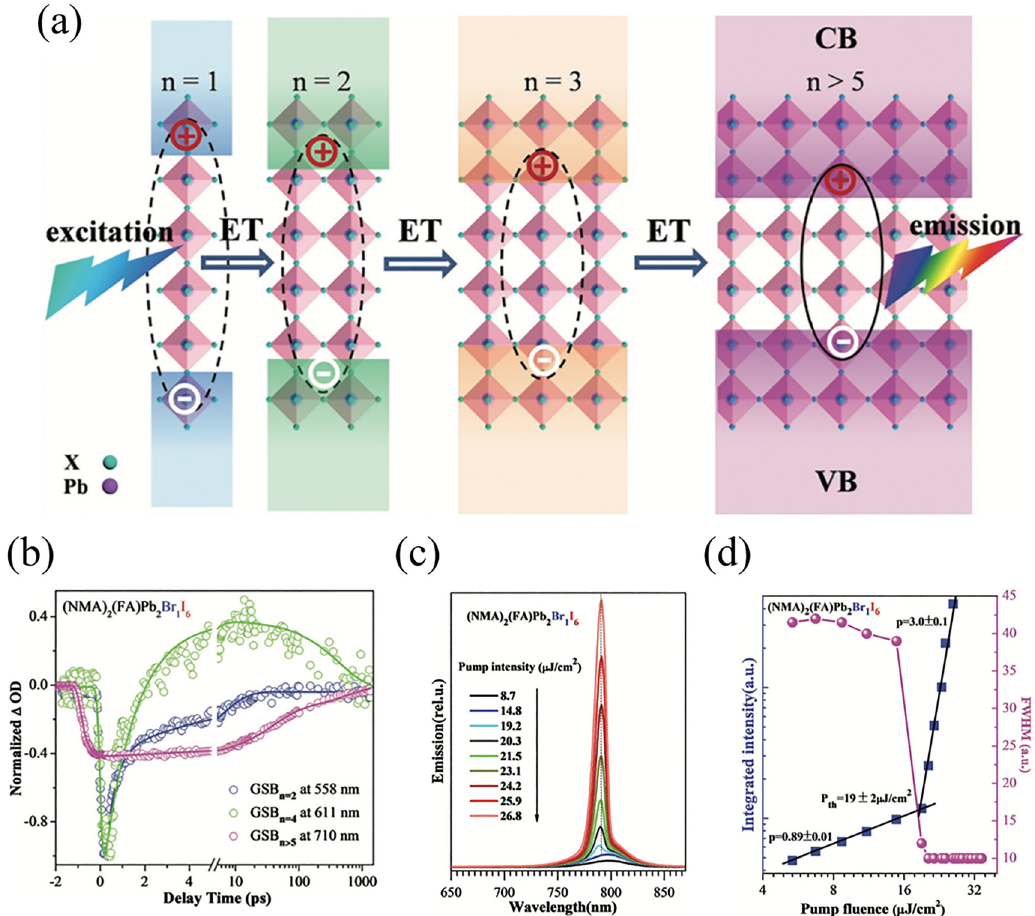
Figure 2: (a) The schematic diagram of cascade energy transfer from low- n domains with wide-bandgap to high- n domains with narrow bandgap. (b) Normalized bleaching kinetics of (NMA) 2 (FA)Pb 2 Br 1 I 6 -based perovskite at the peaks of 558, 611, and 738 nm corresponding to n = 2, 4, and >5 domains. (c) Pump- fl uence-dependent PL spectra for (NMA) 2 (FA)Pb 2 Br 1 I 6 -based perovskite thin fi lms with an thickness of ≈ 75 nm under the pulsed excitation laser (400 nm, 150 fs pulses). (d) Pump- fl uence-dependent emission intensity for (NMA) based perovskite thin fi lms. From the abrupt narrowing FWHM and increased emission intensity as a function of the pump fl uence, ASE propertyfor(NMA) 2 (FA)Pb 2 Br 1 I 6 -basedperovskitethin fi lmscanbeidenti fi ed.Reproducedwithpermission[36].Copyright©2018,WILEY ‐ VCH Verlag GmbH & Co. KGaA,